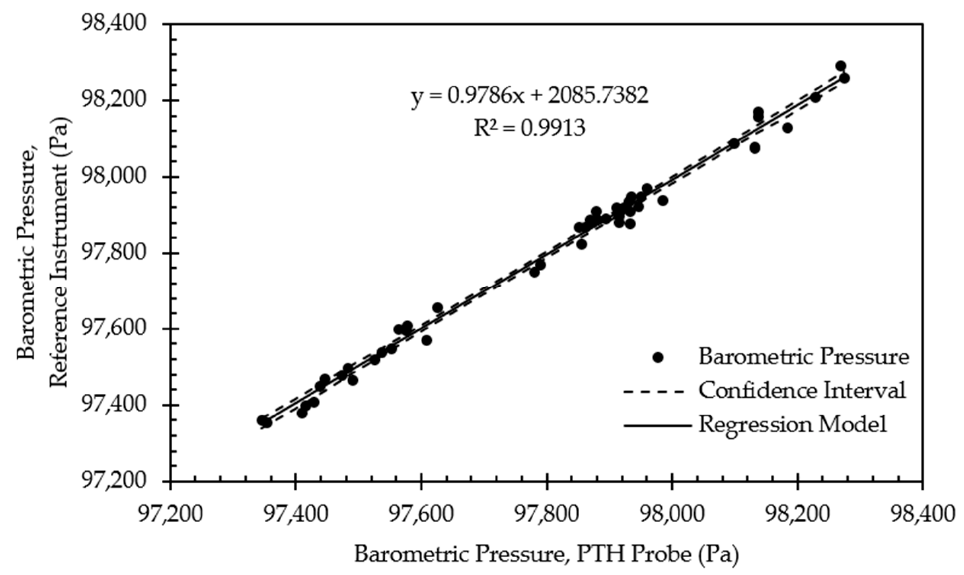
Figure 14. Regression model and corresponding confidence interval for barometric pressure valida- tion data from representative PTH probe (SN: 0x0005).